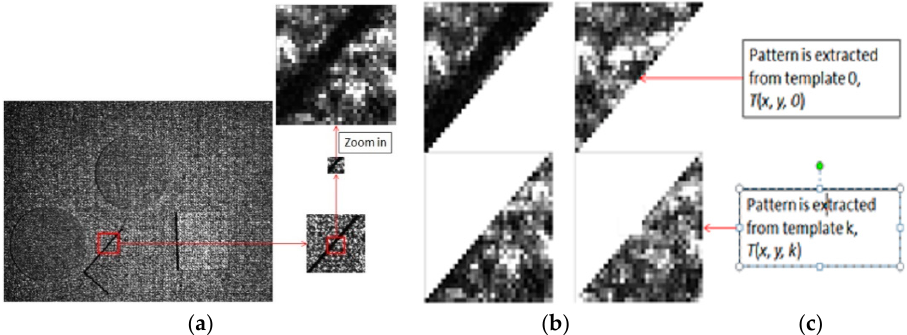
Figure 4. Measured subset image pattern formed by a surface contour edge: ( a ) measured image of multi objects; ( b ) a red square indicating measured subset image pattern along a titling contour edge, which comprises the top-left triangular region, the light diffracted region, and the bottom-right triangular region; and ( c ) two triangular subset images corresponding to their own reference heights.